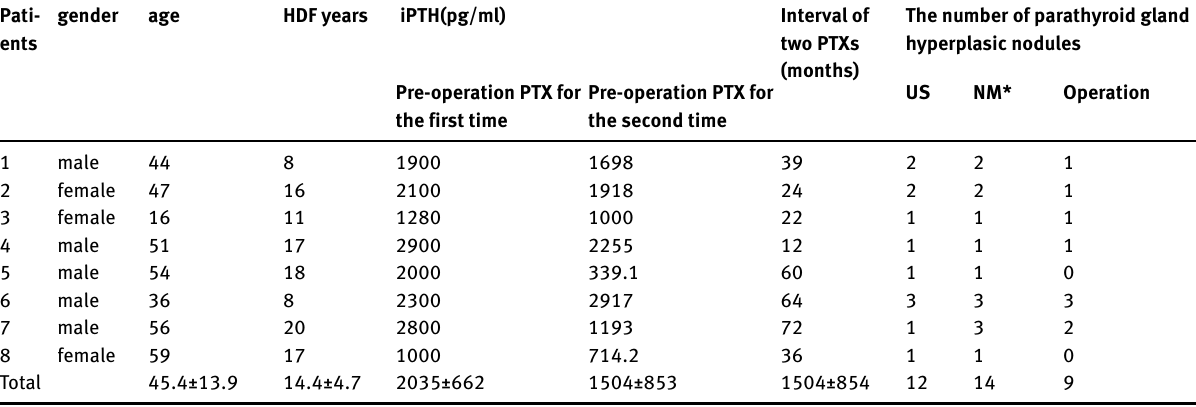
Table 1 Clinical medical history of patients (Note: NM* stands for 99mTc-MIBI SPECT-CT imaging) Pati-